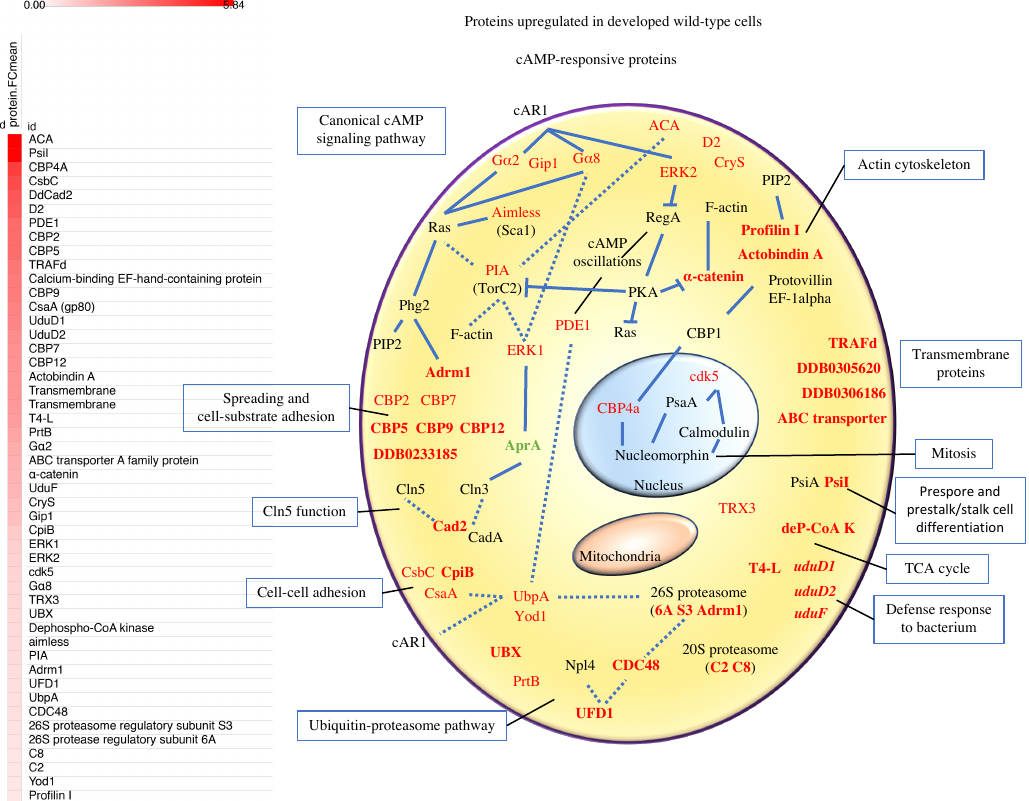
Figure 2. Overview of the cell structure and function. The diagram illustrates the in situ flow of upregulated proteins (mark in red) in early di ff erentiation as a consequence of cAMP stimulation. Novel early developmentally regulated proteins are in bold. Blue lines indicate direct interactions whereas dotted lines indicate they are part of the same signaling pathway or biological